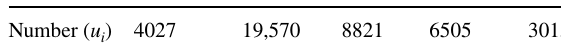
Alternative car ( i )